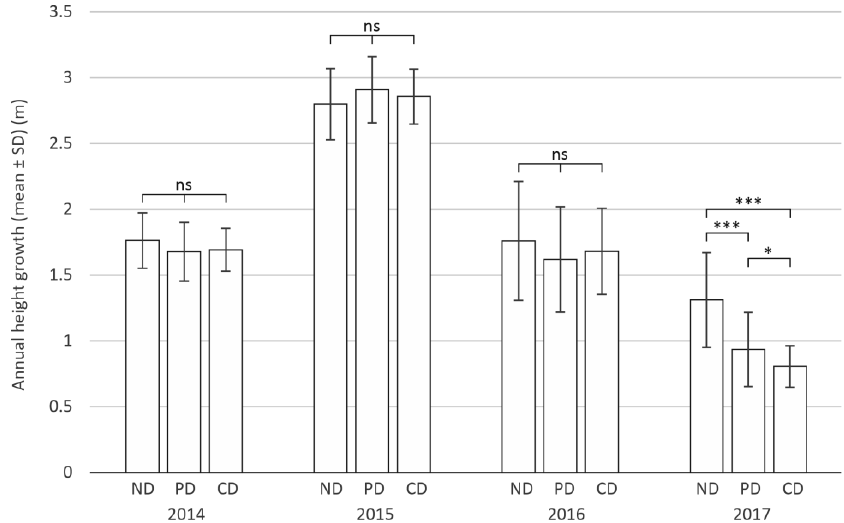
Figure 4. Annual height growth of trees for the period 2014–2017. ND—non-defoliated trees; PD—partially defoliated trees; CD—completely defoliated trees. The symbols above the error bars indicate the significance of the differences between the means of annual height growth depending on defoliation classes according to Tukey’s multiple comparison test ( p < 0.05) (ns—not statistically